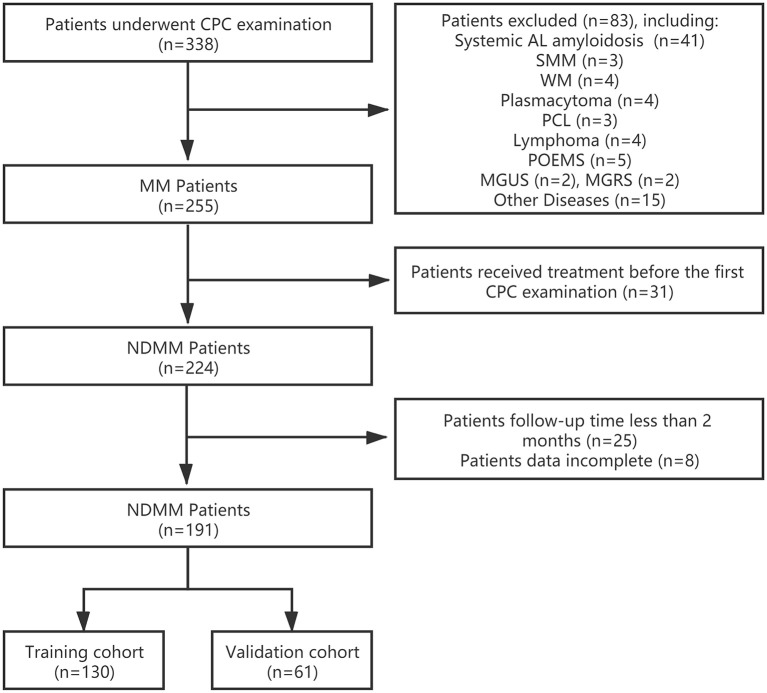
Patient flow diagram. CPC, circulating plasma cells; MM, multiple myeloma; NDMM, newly diagnosed multiple myeloma; systemic AL amyloidosis, systemic light chain amyloidosis; SMM, smoldering multiple myeloma; WM, Waldenström macroglobulinemia; PCL, plasma cell leukemia; POEMS, POEMS Syndrome; MGUS, monoclonal gammopathy of undetermined significance; MGRS, monoclonal gammopathy of renal significance.